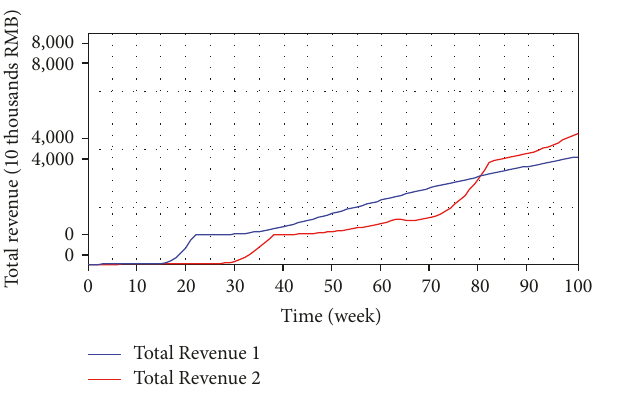
Figure 8: Total Revenu e contrast